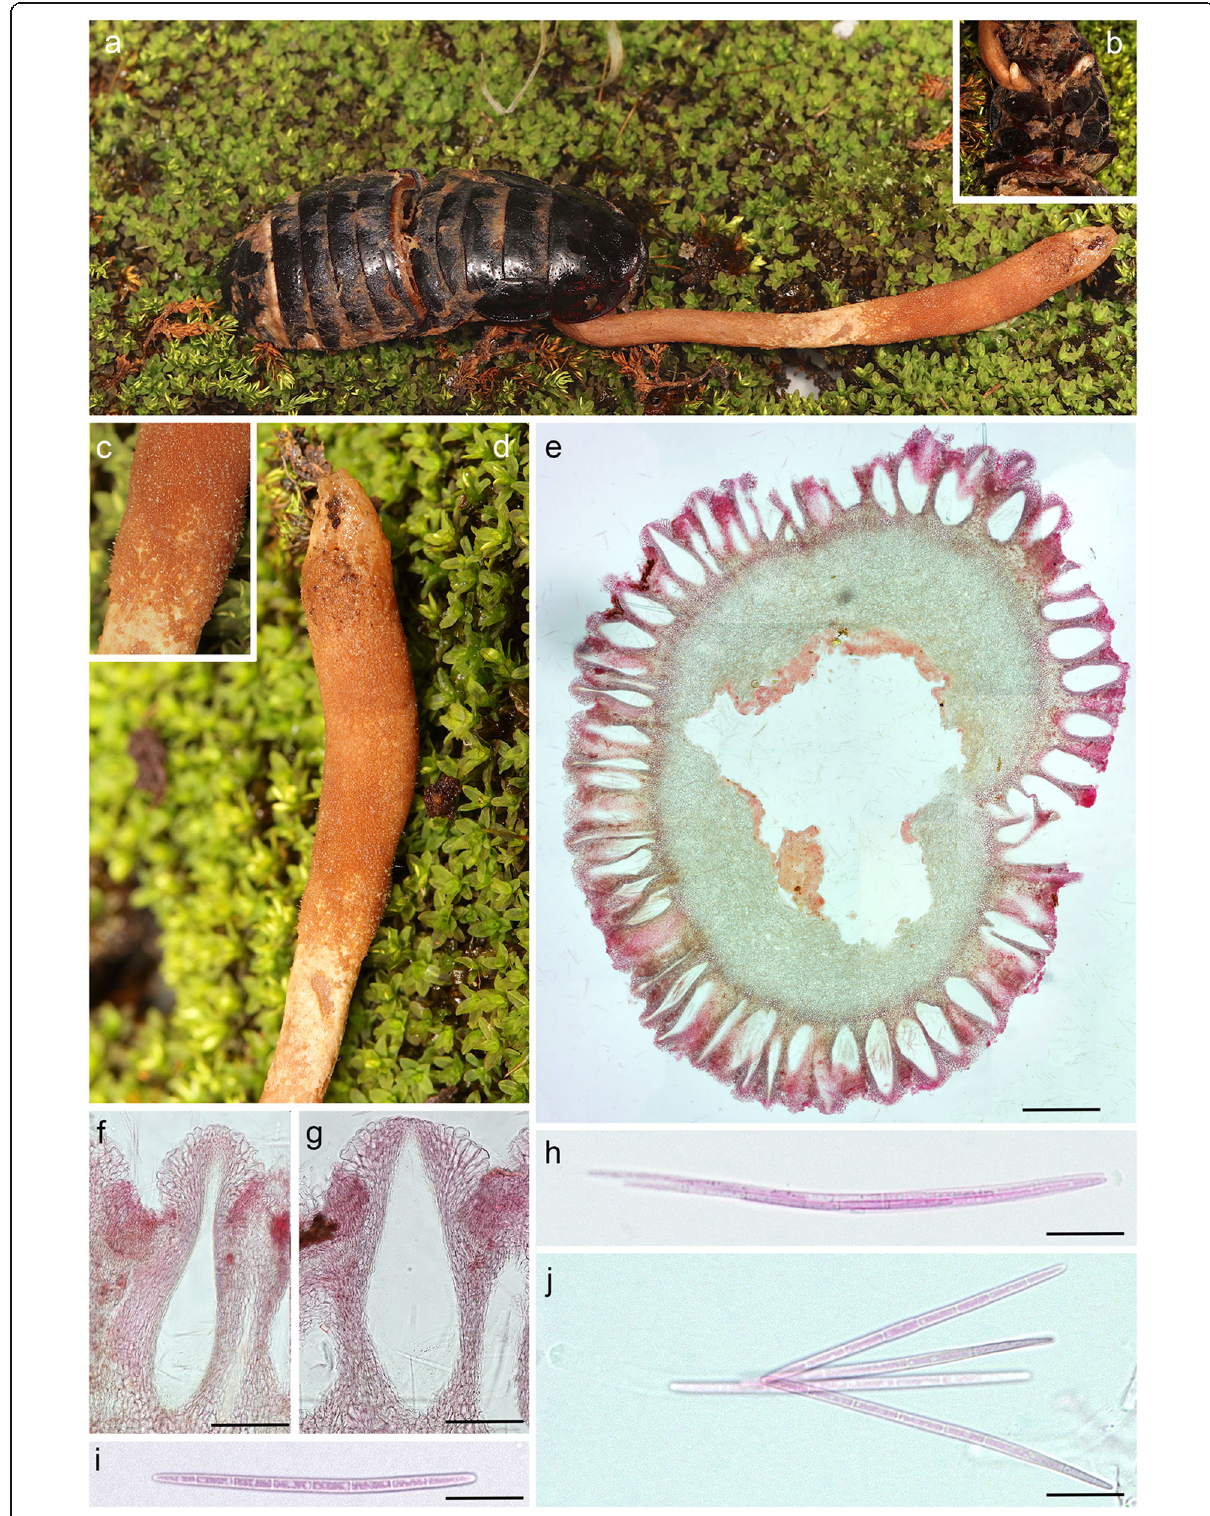
Fig. 7 Ophiocordyceps salganeicola on Salganea esakii (fresh specimen) from Yakushima, Kagoshima (TNS-F-91239). a Salganea esakii with a single robust ascoma; b Close-up showing early stage ascoma arising from ventral pronotum; c and d Close-up of ascoma; e Cross-section of ascoma; f and g Perithecia; h Ascospores within ascus; i and j 8-celled ascospores. Presented as JPMA106 in Fig.